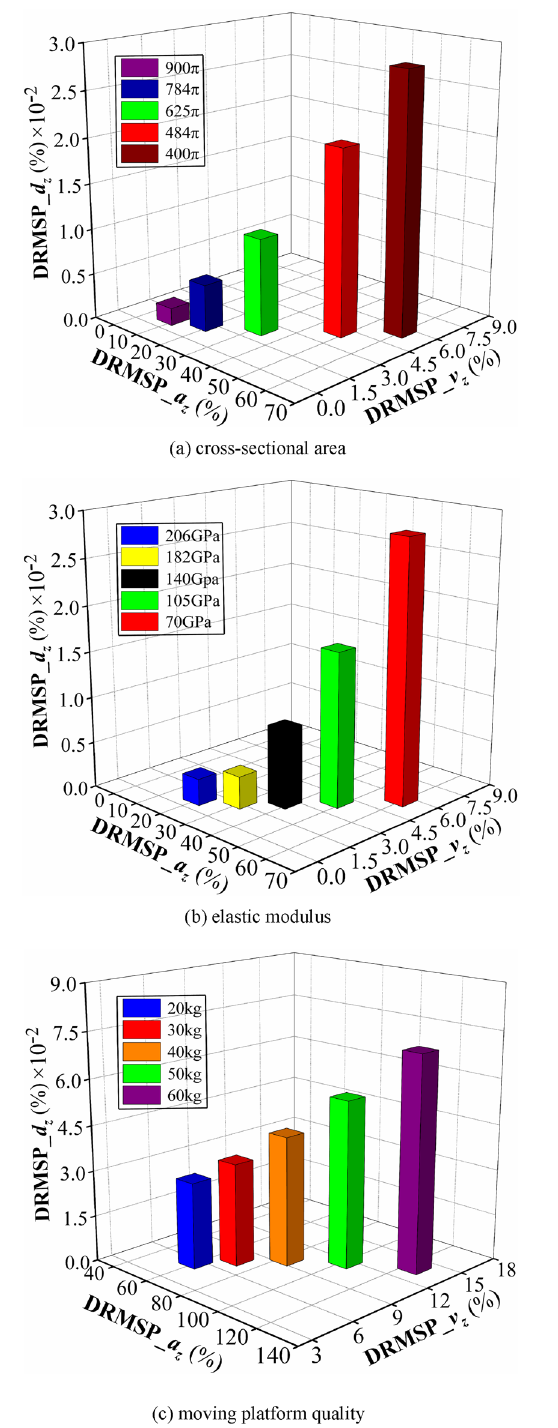
Figure 14 Quantitative analysis of the output DRMSP ( x